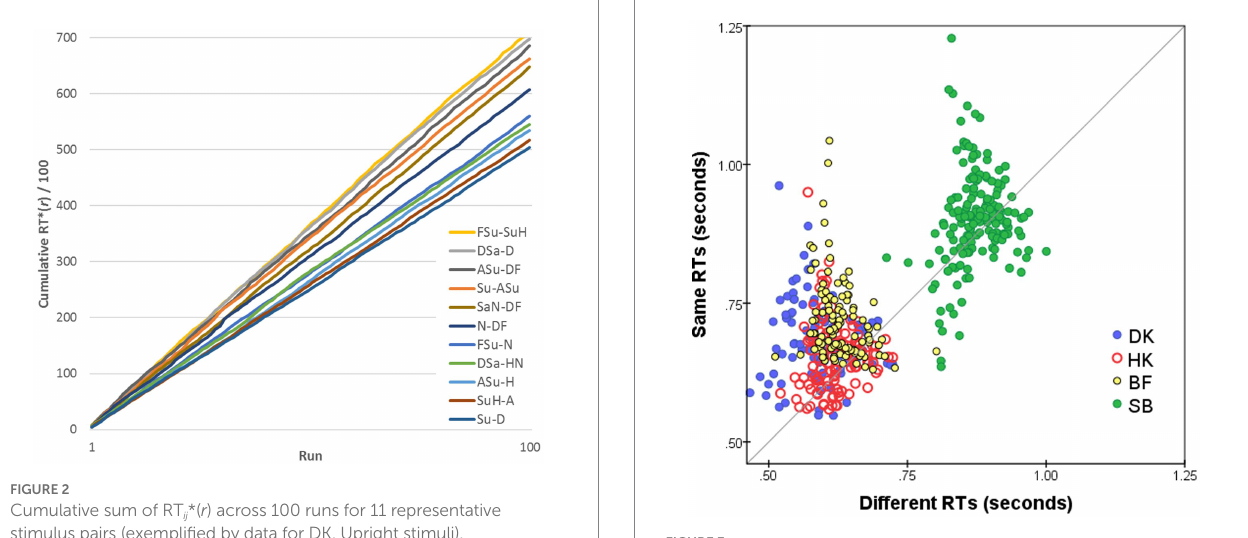
FIGURE 3 Median RT* M S ij for S responses to i -th and j -th FEs, i ≠ j (vertical axis), plotted against M D ij for D responses (horizontal axis). Superimposed results for four observers and for both Upright and Inverted presentation modes. Pairs omitted if four or fewer